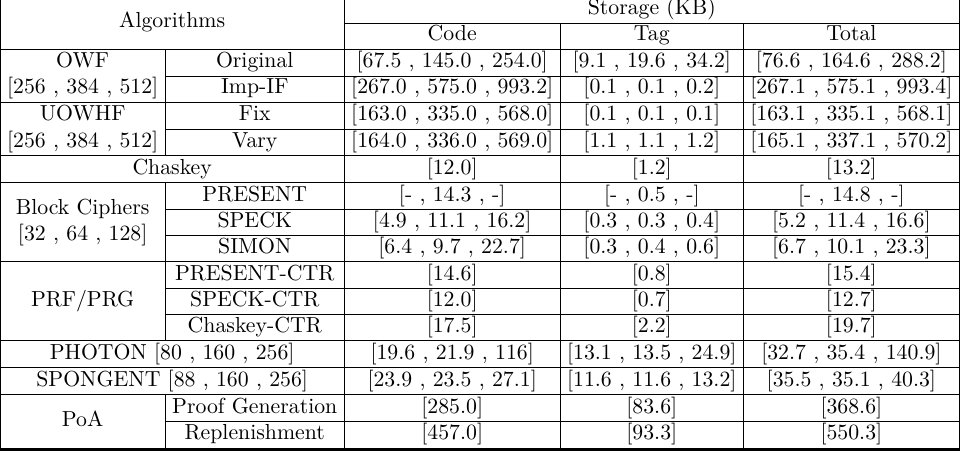
Table 6: Storage Cost of Algorithms in